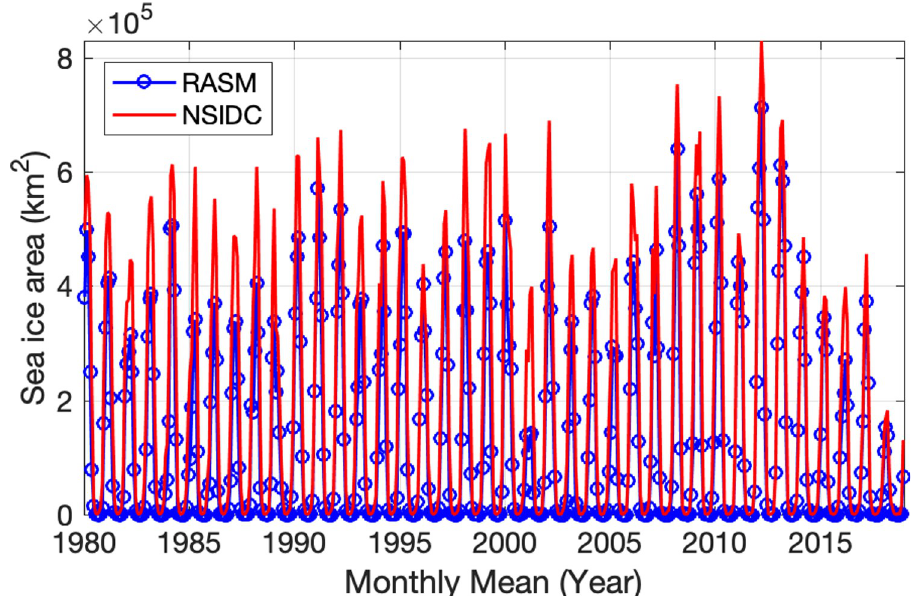
Fig 7. Monthly mean sea ice area. Monthly mean sea ice area (km 2 ) in the Bering Sea calculated from RASM (blue) and the National Snow and Ice Data Center (NSIDC; red) satellite product